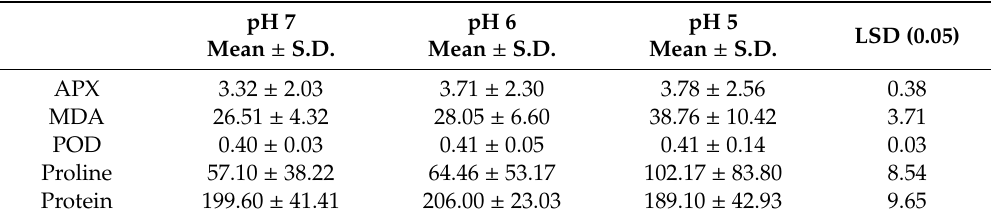
Table 2. Average values of two genotypes and two sampling times for measured parameters for three treatments.